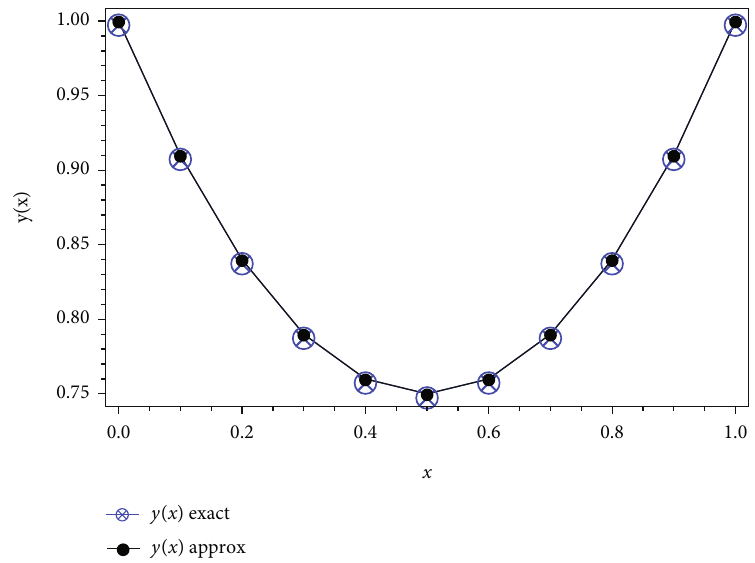
Figure 7: Comparison between the approximate solutions and the exact solutions of Example 5 for N = 4